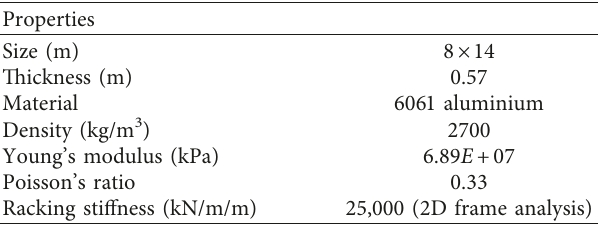
Table 1: Dimensions and properties of the tunnel in the centrifuge test